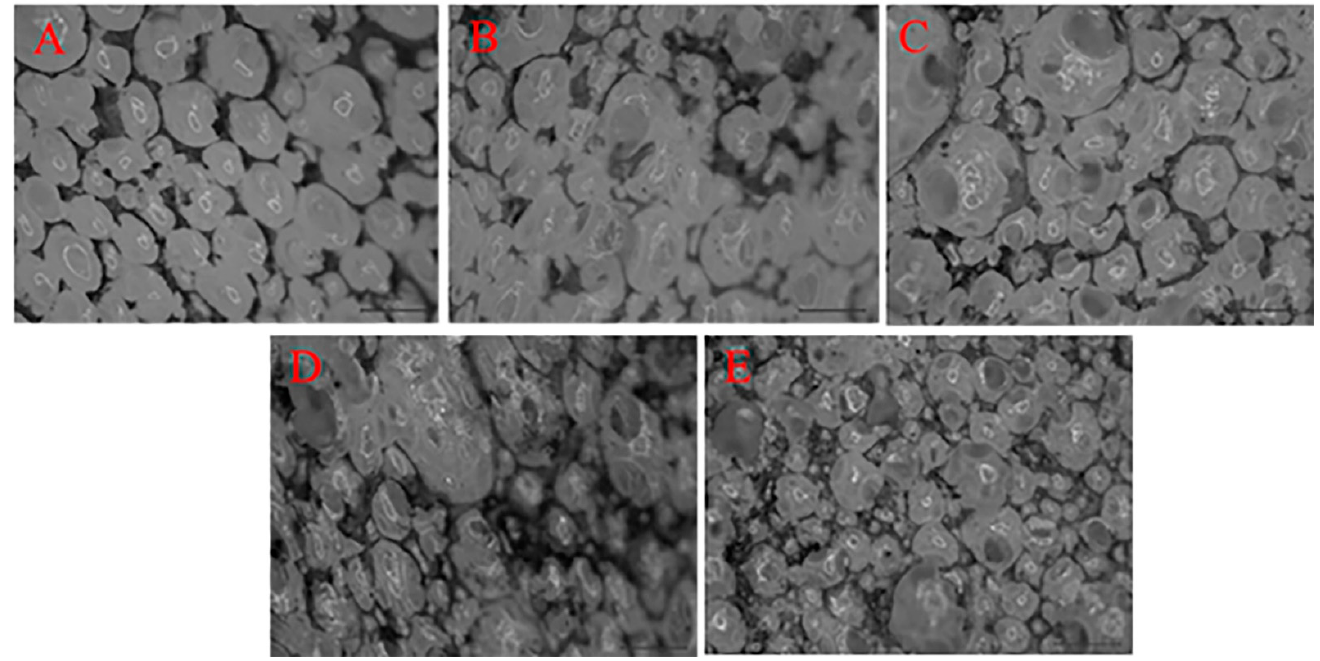
Figure 4. Stereomicroscopic images (magnified by 10 × 4) of ( A ) HCMF0, ( B ) HCMF5, ( C ) HCMF10, ( D ) HCMF15, and ( E ) HCMF20.